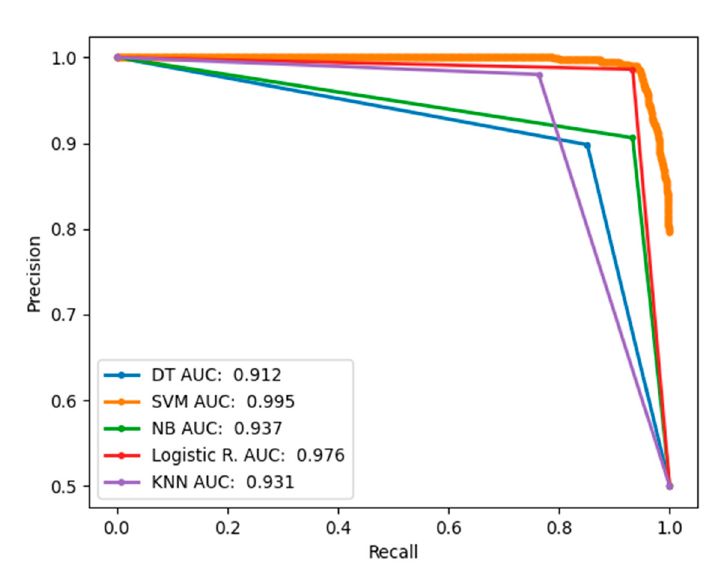
Figure 11. PRC comparing performances of the classifiers using 4096 FC2 features of the VGG16 model.